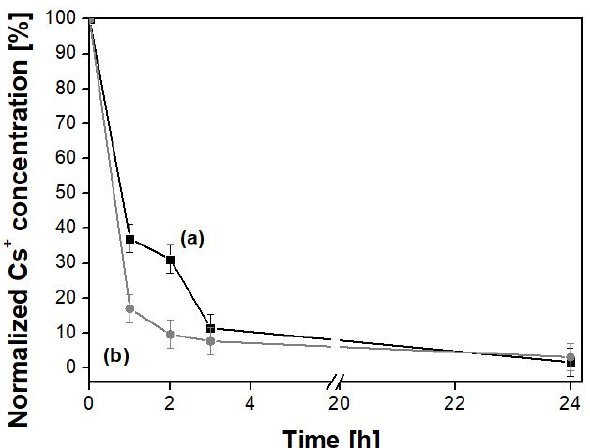
Figure 5. Normalized Cs + concentration in enteric fluid after contact with PB_Com ( ■ , a ) and PB_Syn ( • , b ) samples for 1, 2, 3, and 24 h. Test conditions: total volume = 10 mL; initial 133 Cs concentration = 500 mg / L; PB mass = 20 mg; room temperature. Standard error achieved from the repetition of 3 measurements. A break from 5 h to 20 h is reported in the graph.